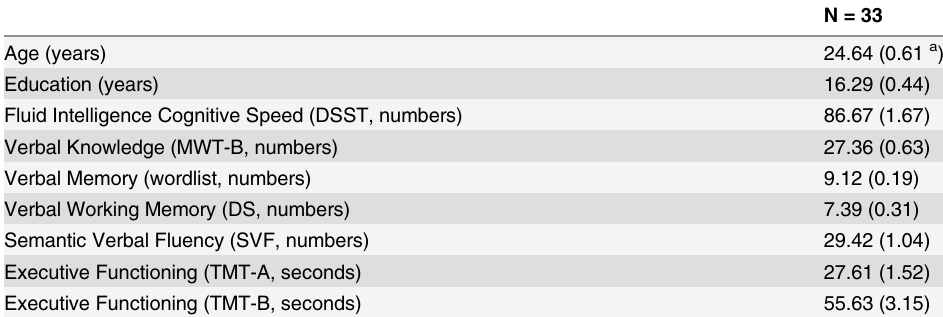
Table 1. Socio-demographic information and results from a neuropsychological battery for the 33 healthy subjects who participated in experiment.